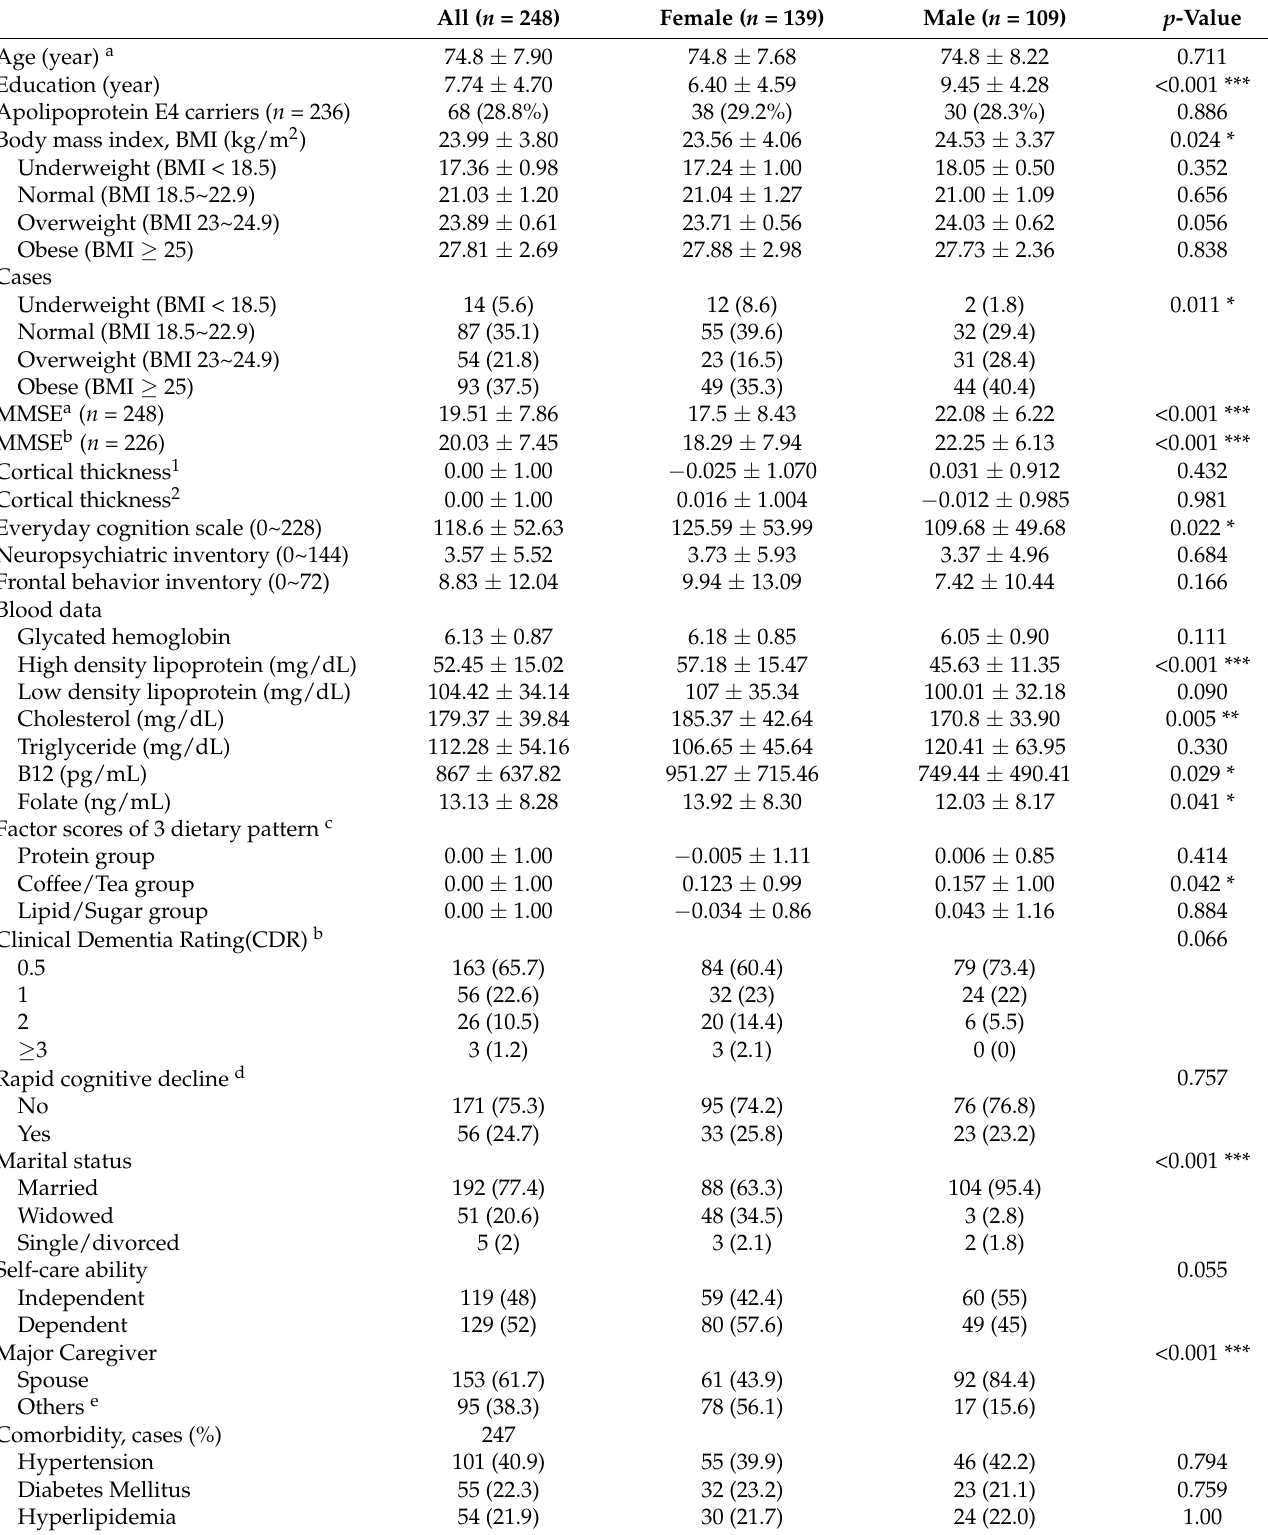
Table 2. Demographic data segregated by